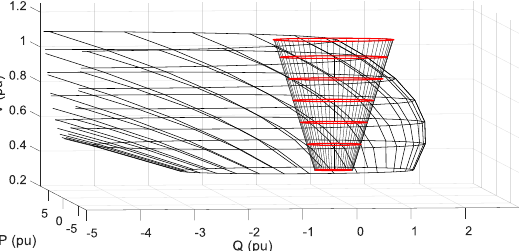
Figure 3. Inverter active and reactive power injection limits depending on the grid voltage. Voltage and current limits are shown separately, where the operational limit is the space within both limits.